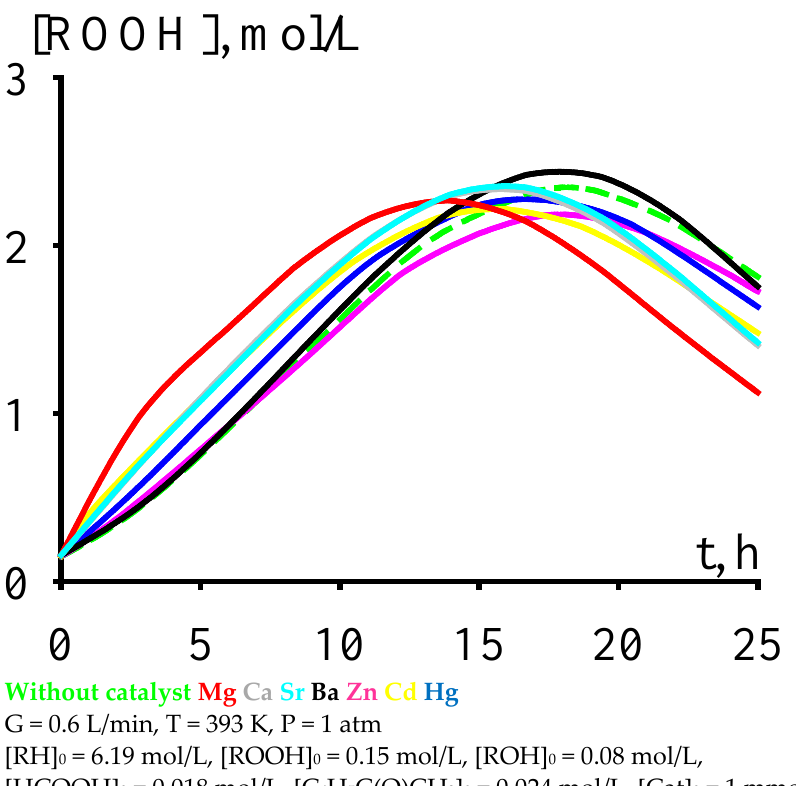
Figure 2. The dependencies of cumene hydroperoxide accumulation versus time.